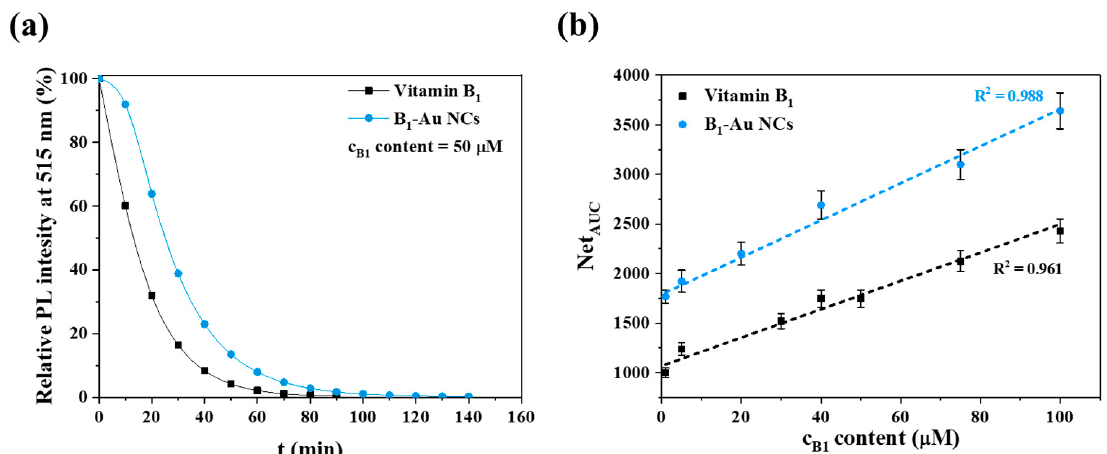
Figure 3. ( a ) The representative kinetic curves of fluorescence decay during the ORAC test in the presence of Vitamin B 1 ( ■ ) and B 1 -Au NCs ( ● ) (B 1 content of 50 µM, T = 25 °C, λ ex = 485 nm). ( b ) The antioxidant dose-response curves between 1 and 100 µM of B 1 content.